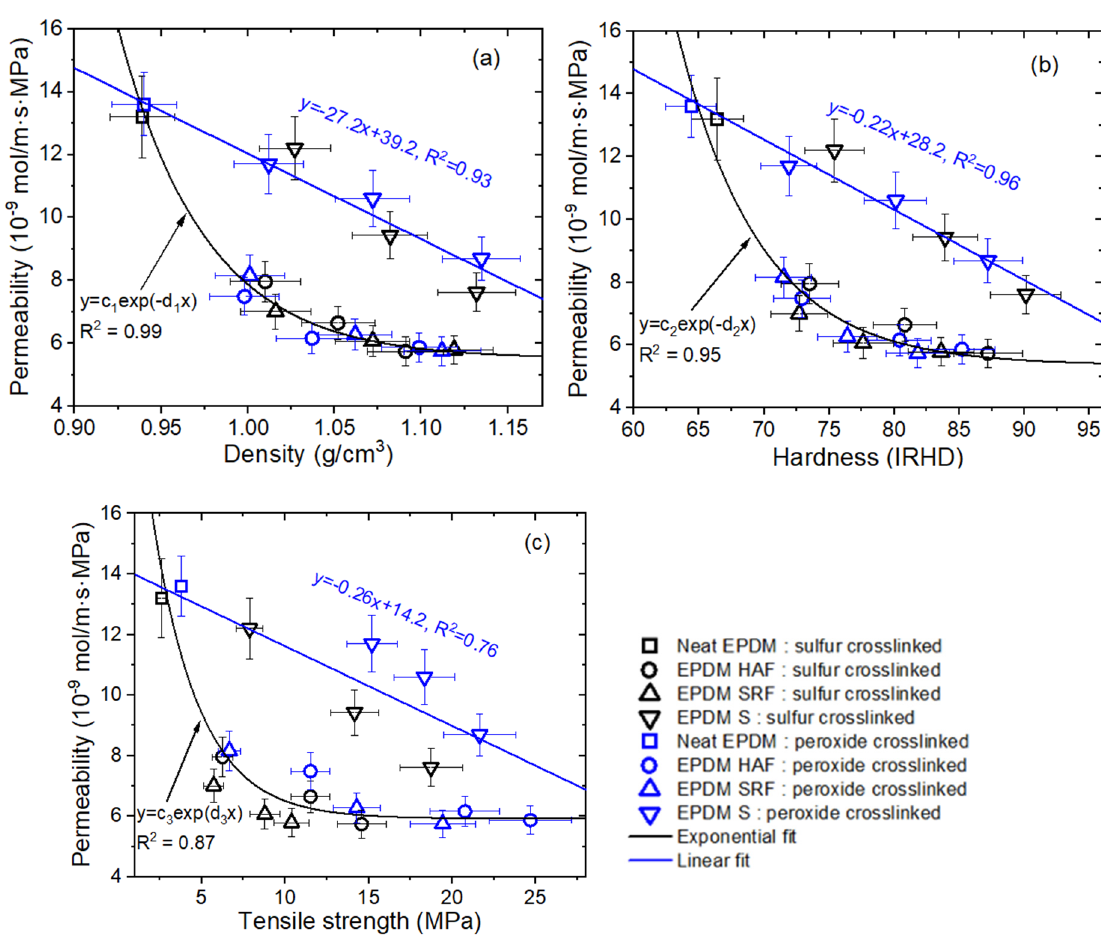
Figure 8. Correlations between permeability and ( a ) density, ( b ) hardness, and ( c ) tensile strength for EPDM composites blended with CB and silica. The data for neat EPDM were included to show consistency with the fits for filled blended EPDM composites. The blue lines indicate negative linear fits, and the R 2 values are indicated. The black lines indicate fits with an exponential decay, and the R 2 values are indicated.